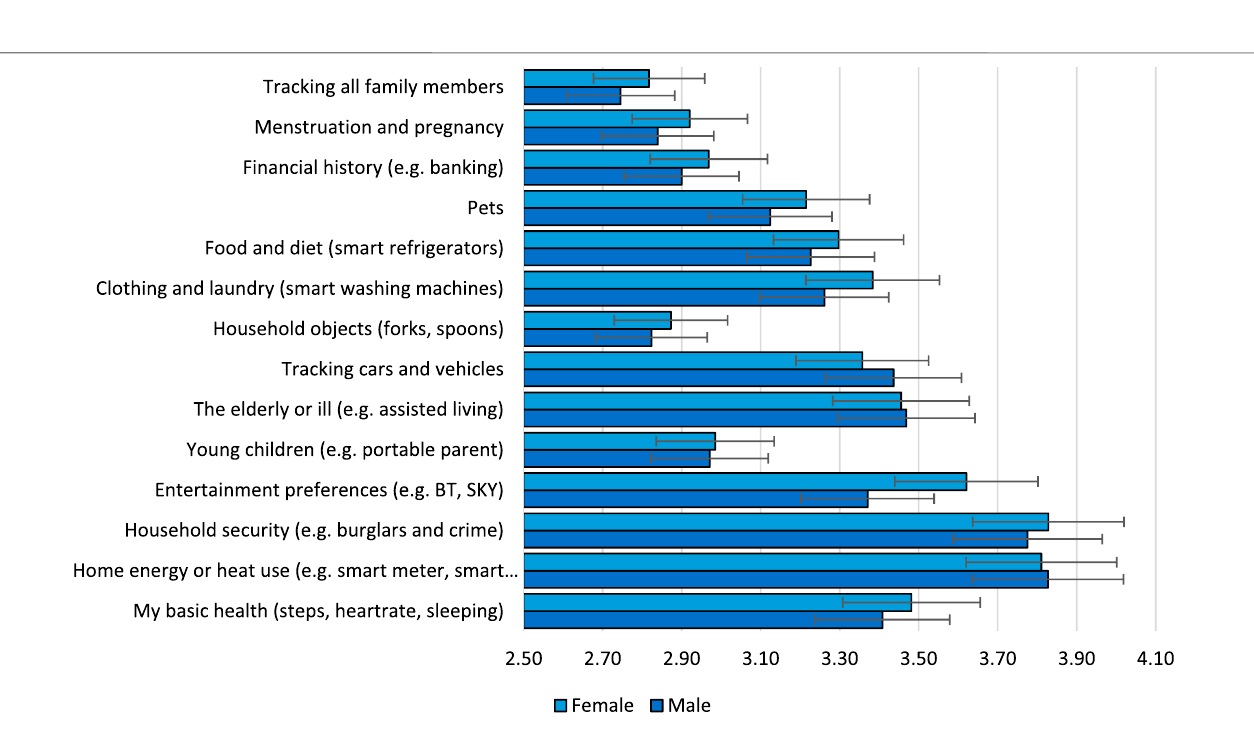
FIGURE3| Differencesinmeanscoresforthe ‘ Iamcomfortablewithsmartsystemsmonitoring ’ (Likertscaleof1 – 5,with5 (cid:1) stronglyagree).Source.authors.Error bars indicate 95% con fi dence